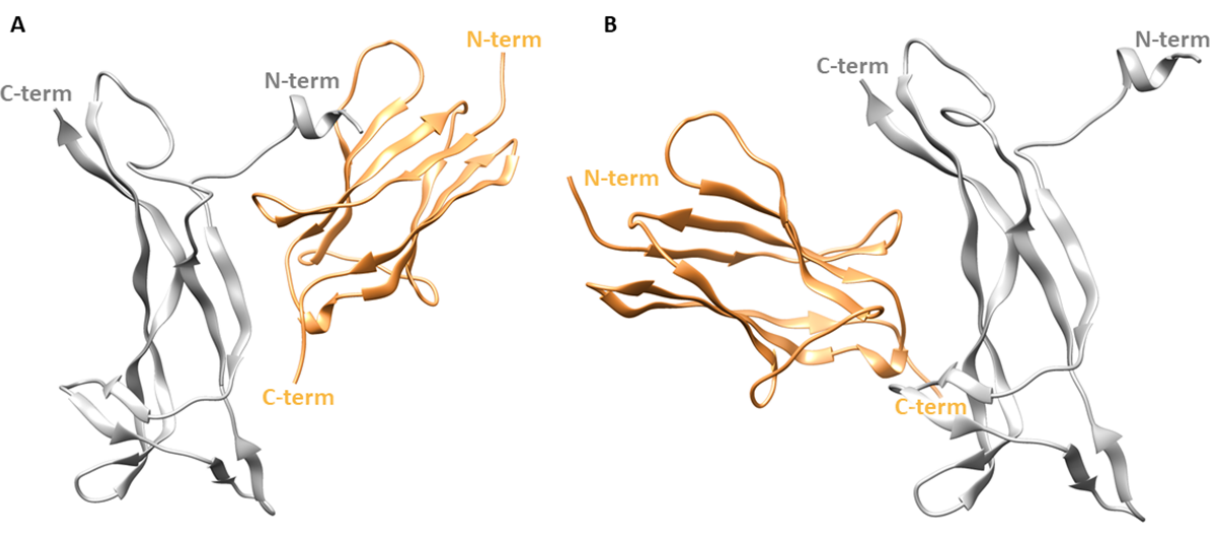
Figure 3. Structures of the two simulated complexes. ( A ) Complex-S comprising the specific patch as binding interface. ( B ) Complex-C including the conserved patch. NGF is represented as gray ribbons while TrkA is displayed as sand-colored ribbons. The image was created by using Chimera software.